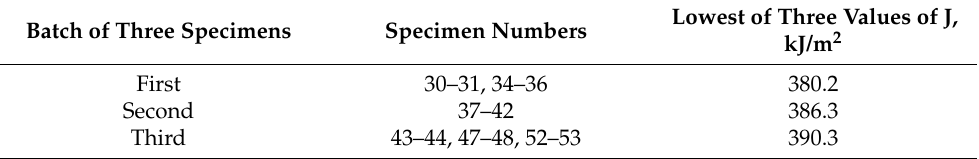
Table 7. Examples of results from separate batches of six valid